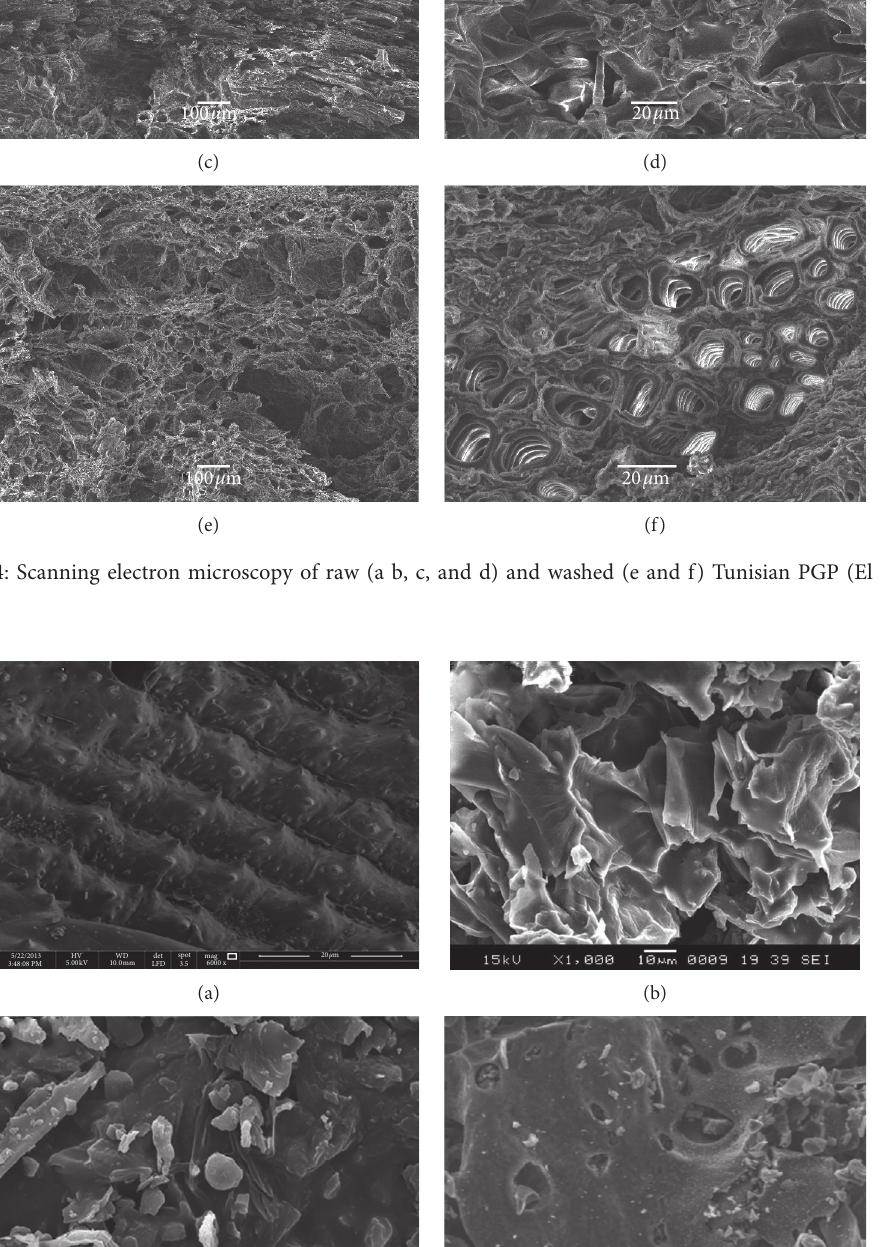
5/22/20133:48:08 PM HV5.00kV WD10.0mm det LFD spot 3.5 mag 6000 x